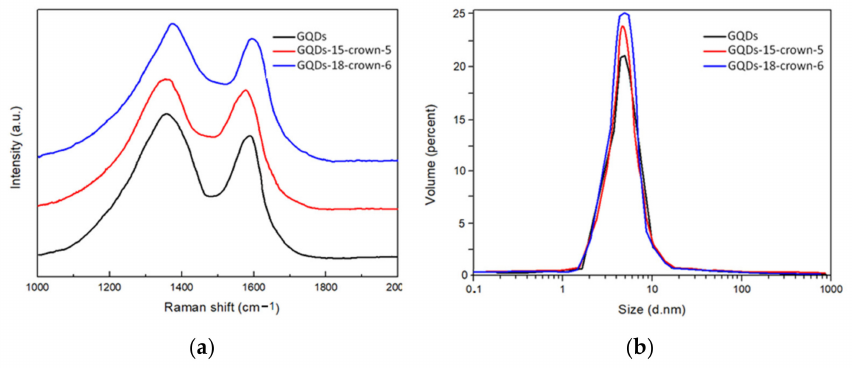
Figure 2. ( a ) Raman spectra of GQDs, GQDs-15-crown-5 and GQDs-18-crown-6; ( b ) DLS mea- surements of GQDs, GQDs-15-crown-5 and GQDs-18-crown-6; all experiments were performed in deionized